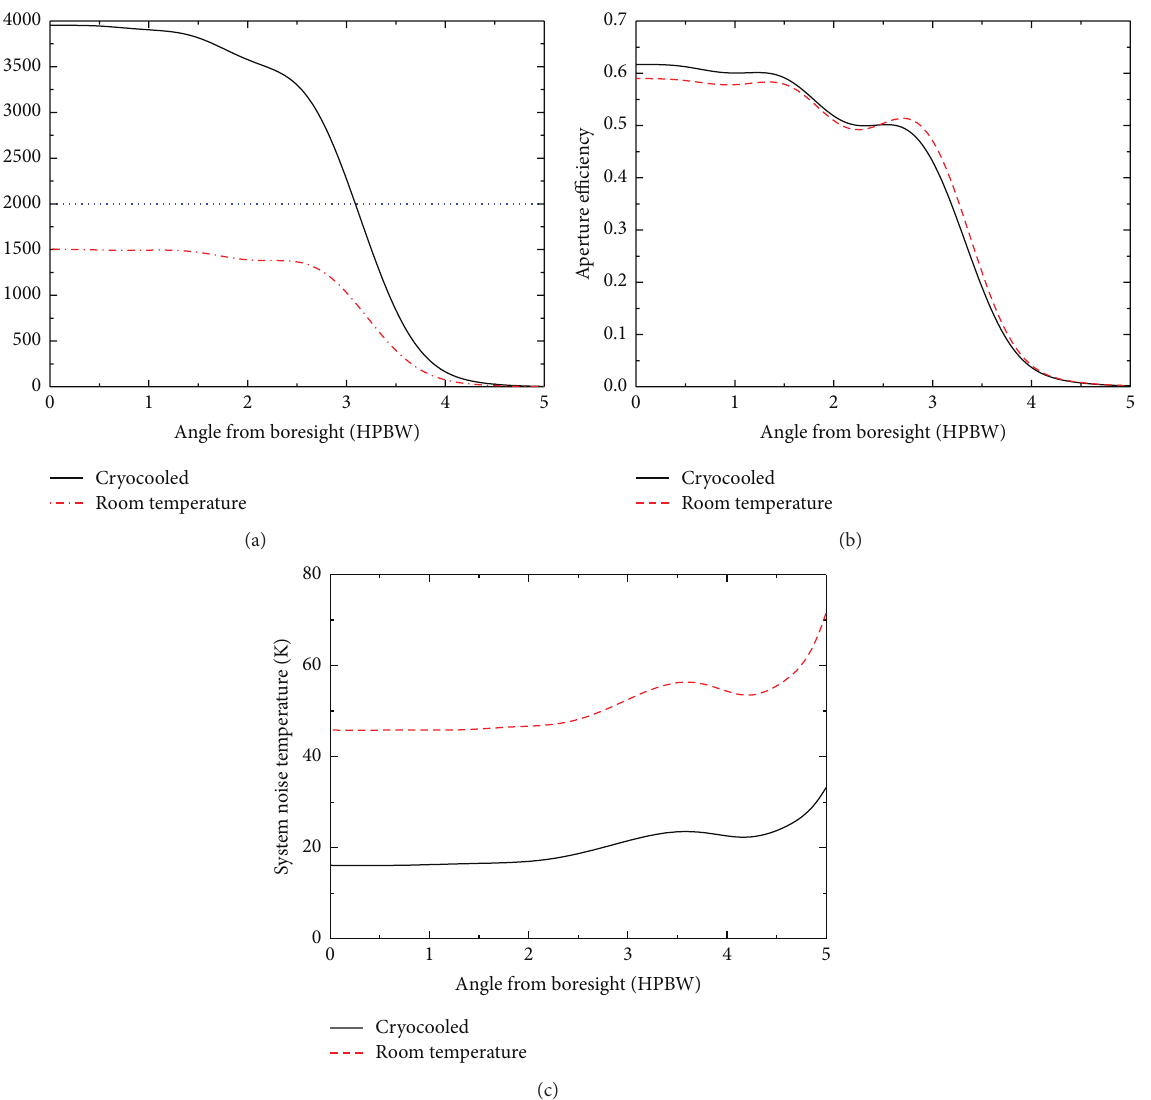
Figure 15: System performance of the 37-element PAF with room temperature and cryocooled LNA. (a) Sensitivity. (b) Aperture efficiency. (c) System noise temperature.